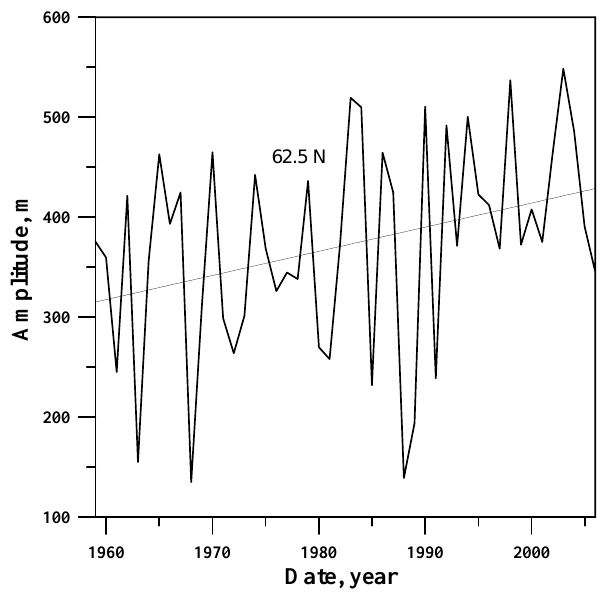
Fig. 12. The long-term change in SPW1 amplitudes in the geopo- tential height at the 30hPa level and at 62.5N latitudes. The esti- mated linear rate is also shown.